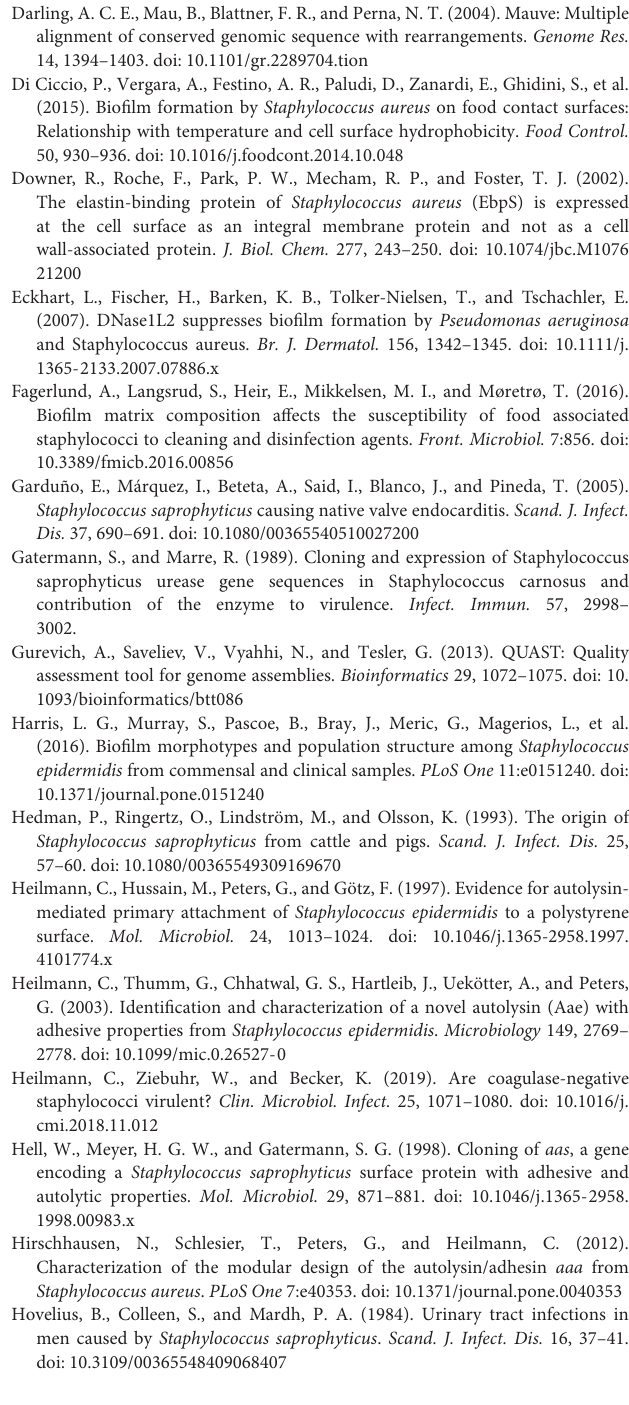
Supplementary Figure 4 | Structure and comparison of ica gene cluster found in a S. saprophyticus recovered from food-related environment and belonging to lineage G. Blocks of identical color represent nucleotide sequence homology between regions found in the two species. Darker shade colored region depicts highest homology and genes are represented by arrows facing the direction of transcription. All the ica genes including some of the genes in its vicinity are highly similar ( ≥ 98% nucleotide sequence) with those found in S. cohnii. The vicinity of